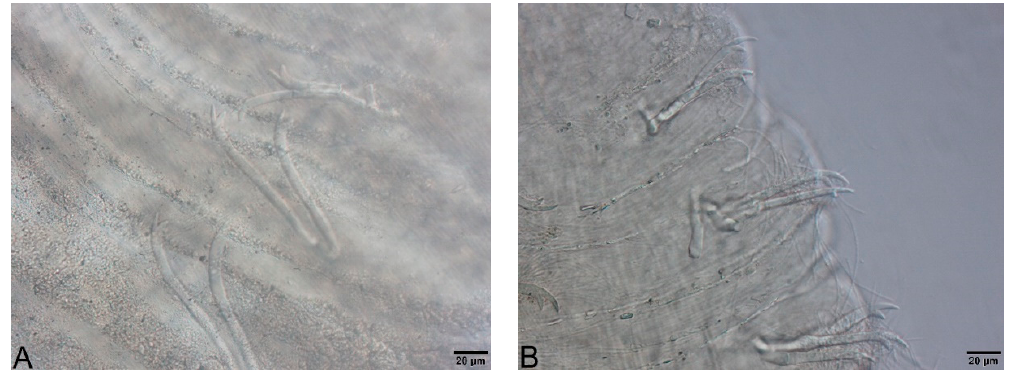
Figure 6. ( A ): Anterior ventral chaetae (segments II to IV) of Spirosperma ferox . ( B ): Anterior ventral chaetae (segments II to IV) of Quistadrilus multisetosus . Author: Régis Vivien.